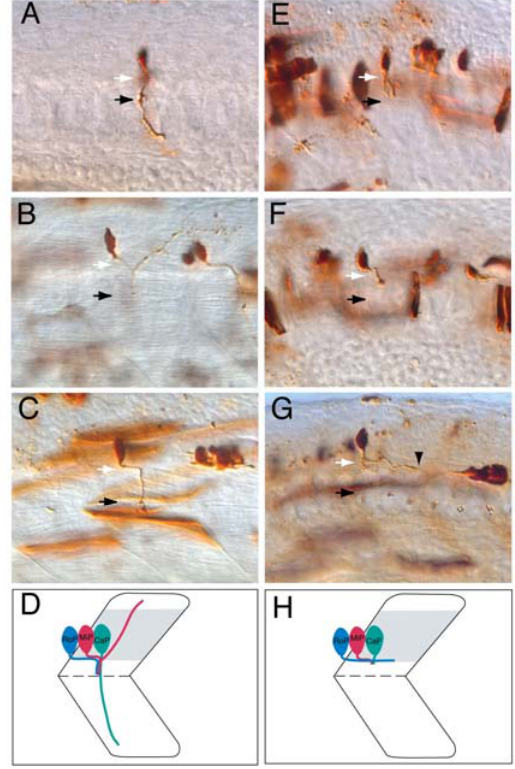
Figure 4. diwanka is required for motor axon exit in zebrafish embryos. ( A – D ): Wild-type axonal projections of CaP ( A ), MiP ( B ), and RoP ( C ) primary MNs labeled with fixable dyes as previously described [12]. White arrows indicate the lower half of the spinal cord, which is out of the focal plane, whereas black arrows indicate the choice point, the distal end of a common path followed by CaP, MiP, and RoP motor growth cones prior to their divergence into ventral, dorsal and medial myotomal regions, respectively ( D ); ( E – H ): In diwanka mutants, CaP ( E ) and MiP ( F ) axons extend wild-type projections within the spinal cord, however they exhibit abnormal projections along the common path (black arrow). Notably, the majority of RoP axons fail to exit the spinal cord in diwanka mutants and instead extend their axons caudally within the CNS (black arrowhead points to a RoP growth cone) ( G , H )